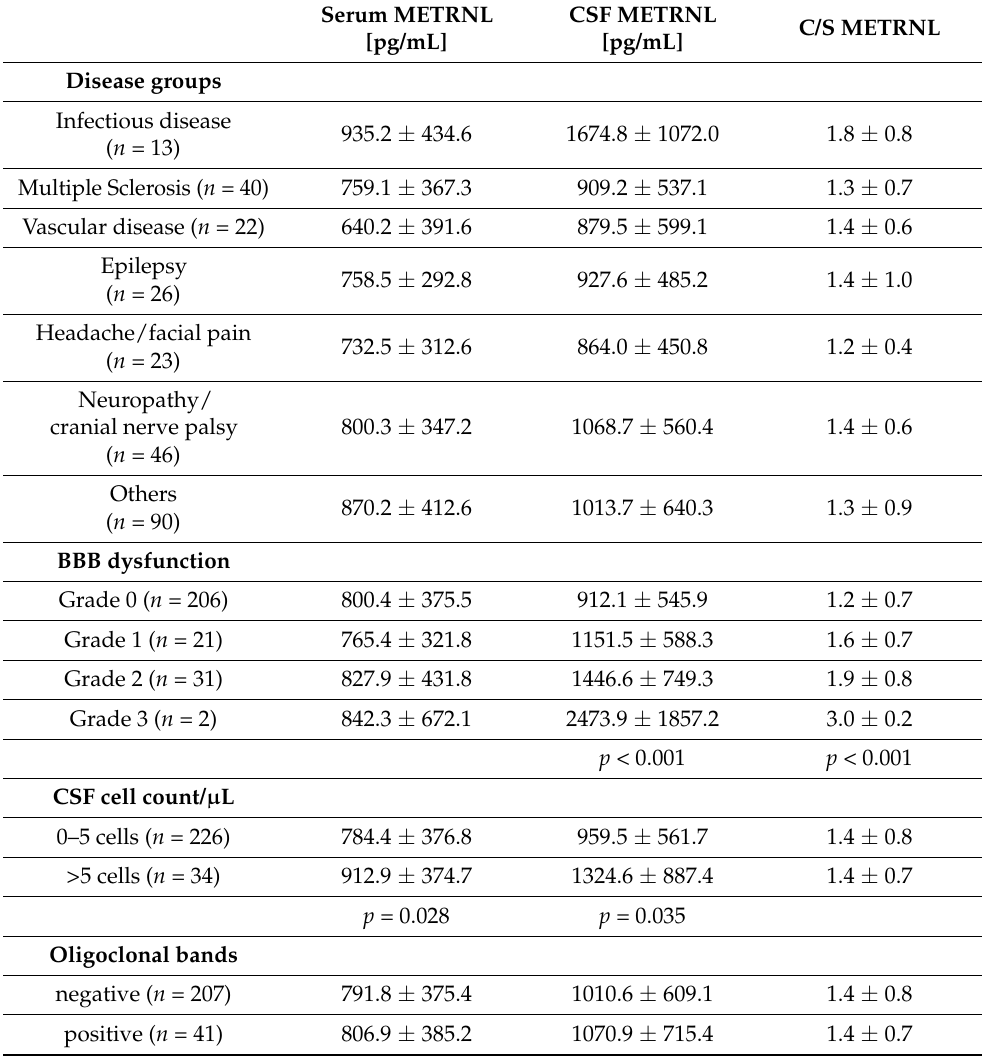
Table 3. Serum concentrations, CSF concentrations, and CSF/serum (C/S) ratios for METRNL (Meteorin-like protein) in subgroups of disease entities and in BBB dysfunction. p -values were calculated applying the Mann–Whitney U -test for two subgroups and the Kruskal–Wallis test for more than two subgroups. BBB, blood–brain